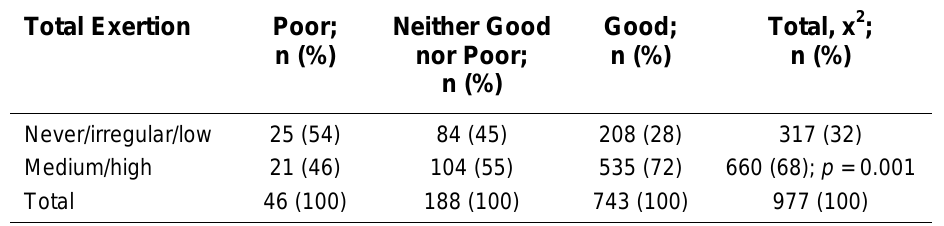
Self-Related Health and Its Relation to Level of Exertion (n = 977, 16 People Missing)